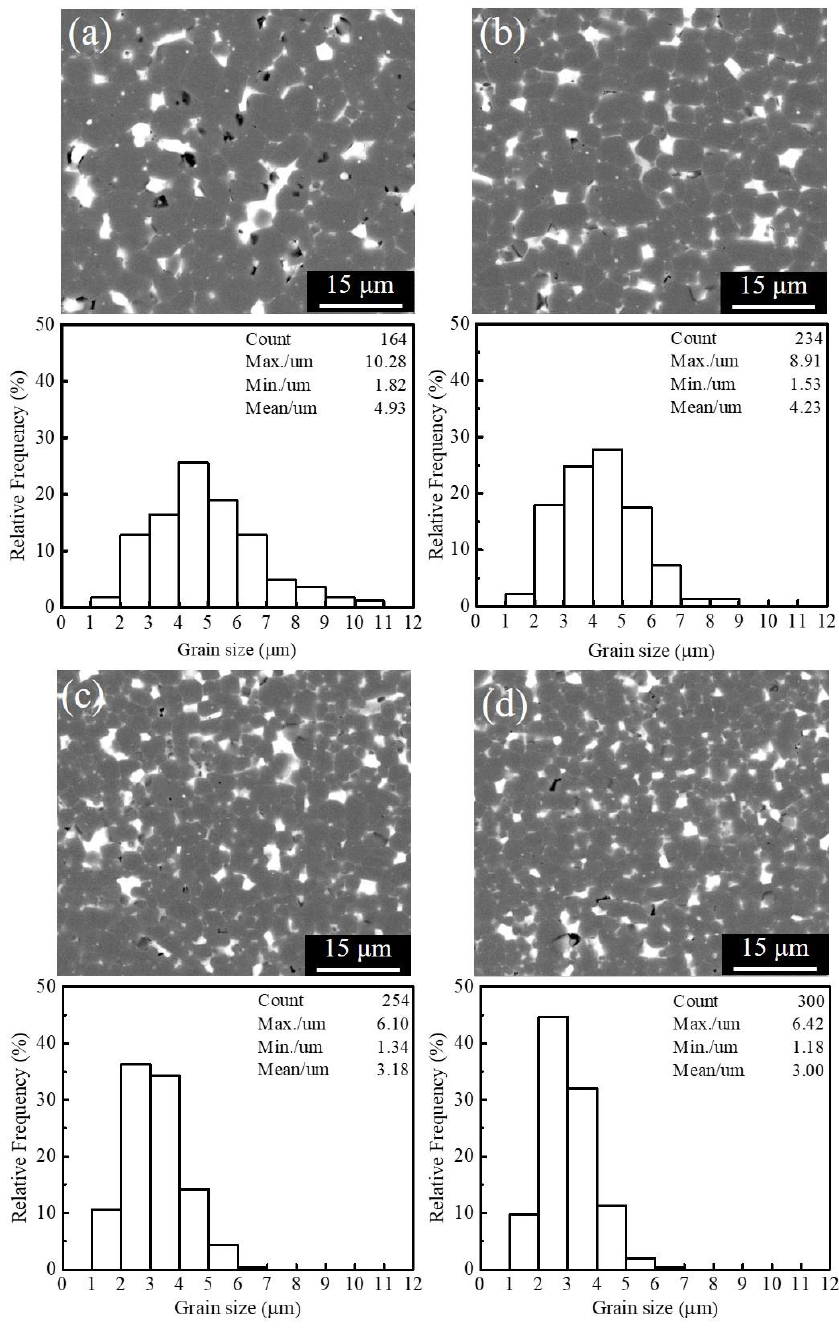
Figure 1. BSE SEM images and corresponding grain size distributions after sintering of magnetic powders with different particle sizes, ( a ) G4.9, ( b )G4.2, ( c )G3.2, ( d )G3.0.